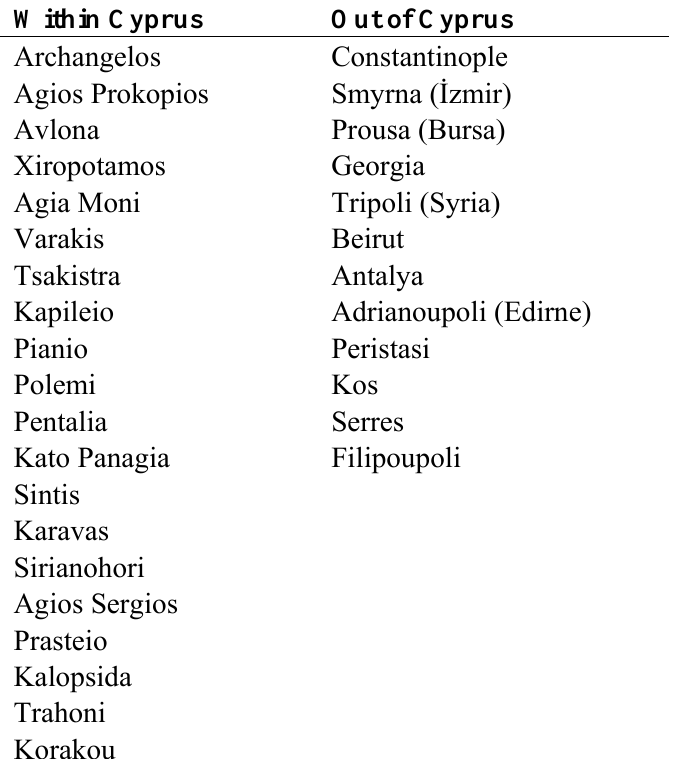
Table 1. Annexes ( metochia ) of the Kykkos Monastery during the Ottoman period